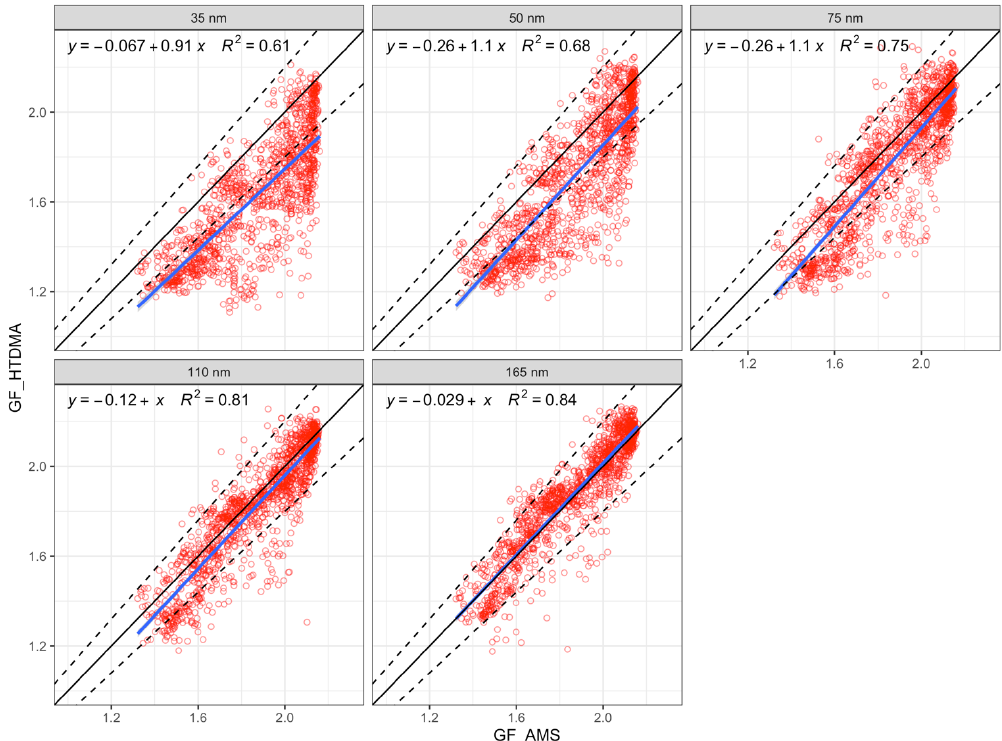
Figure 6. The comparison of bulk GF_AMS with size-dependent GF_HTDMA. The 1 : 1 line is shown in black; the 10% deviation is indicated by the dashed lines; the blue line is the regression line y = b + a × x ; and R 2 is the regression coefficient